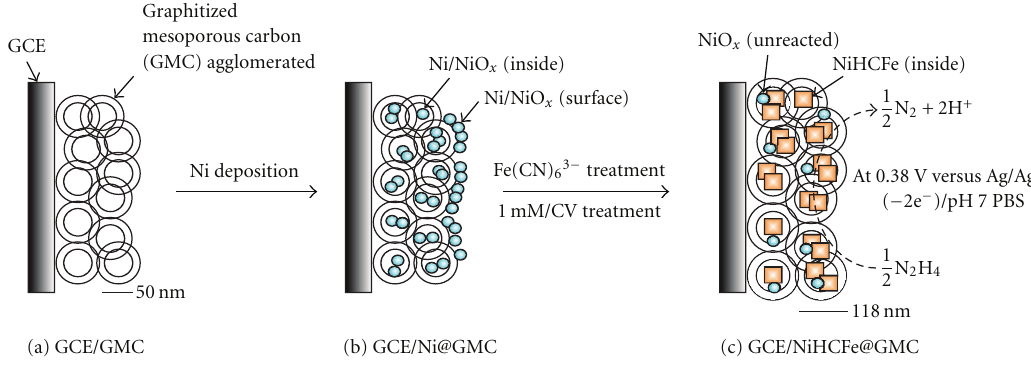
Scheme 1: Illustration for the in situ precipitation of NiHCFe units within GMC by a sequential preparation